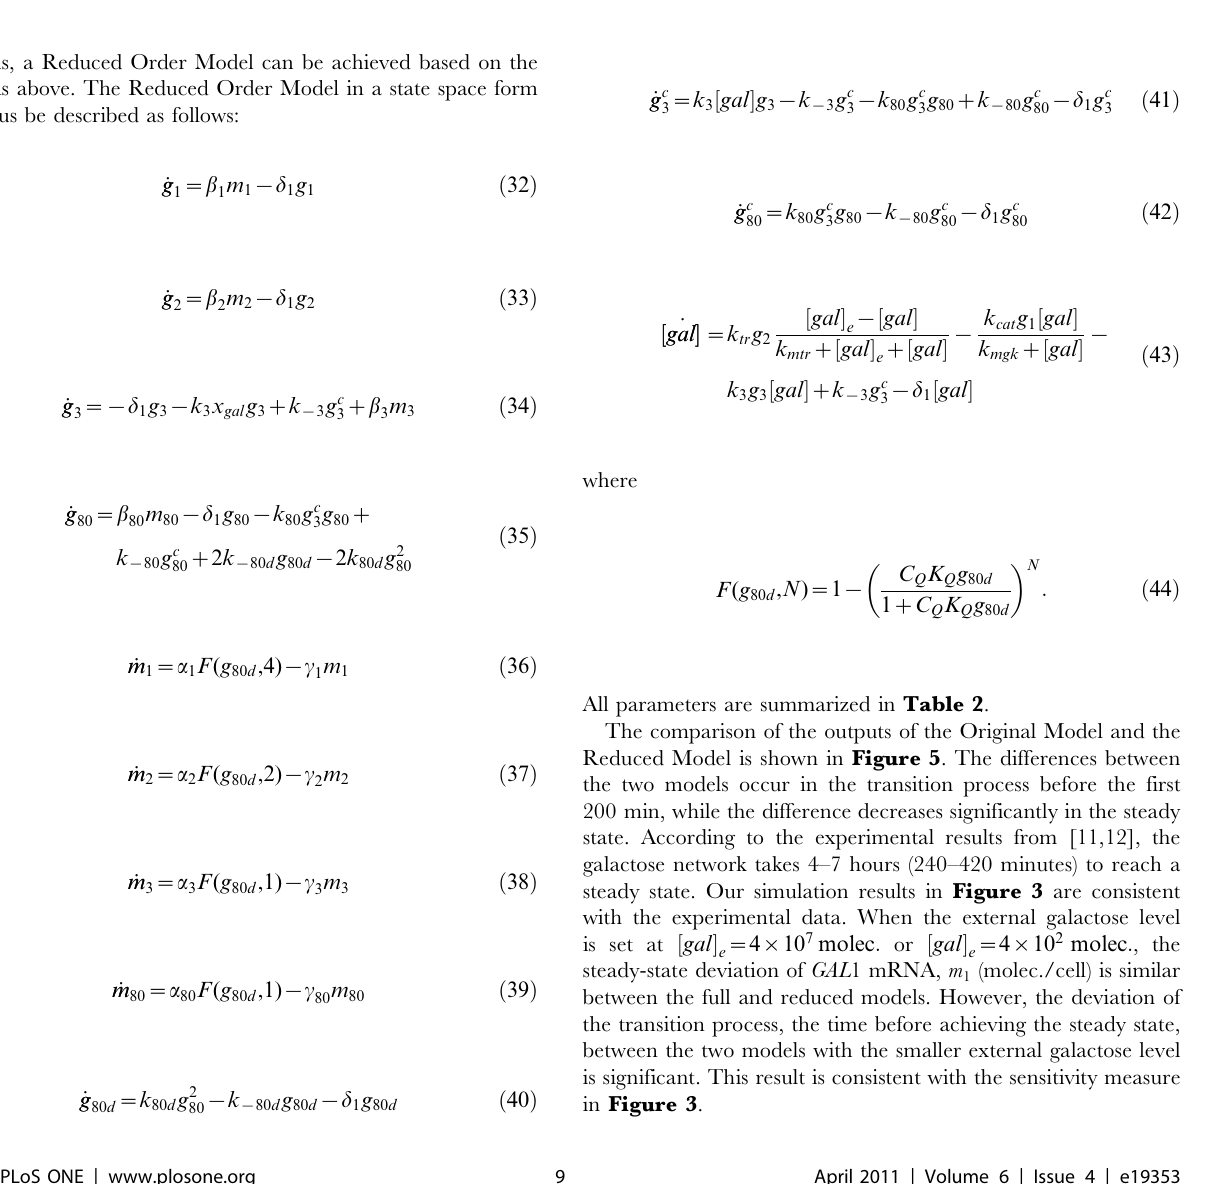
Figure 4. Global sensitivity analysis at the steady states of four GAL mRNAs with respect to all model parameters under constant ~ 4 | 10 7 molec . The bars denote the range of the sensitivity coefficients of four GAL mRNAs with respect to each parameter. The blue control ½ gal (cid:3) e solid line stands for the global sensitivity coefficients for GAL 1 mRNA.